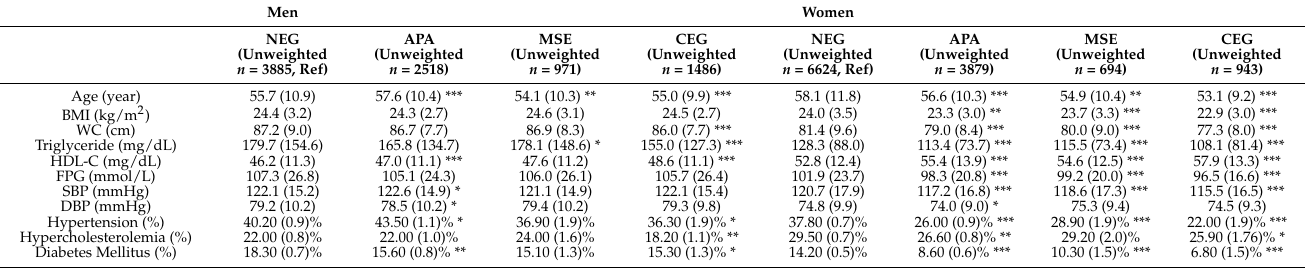
Table 2. Metabolic profiles of study participants according to exercise groups.